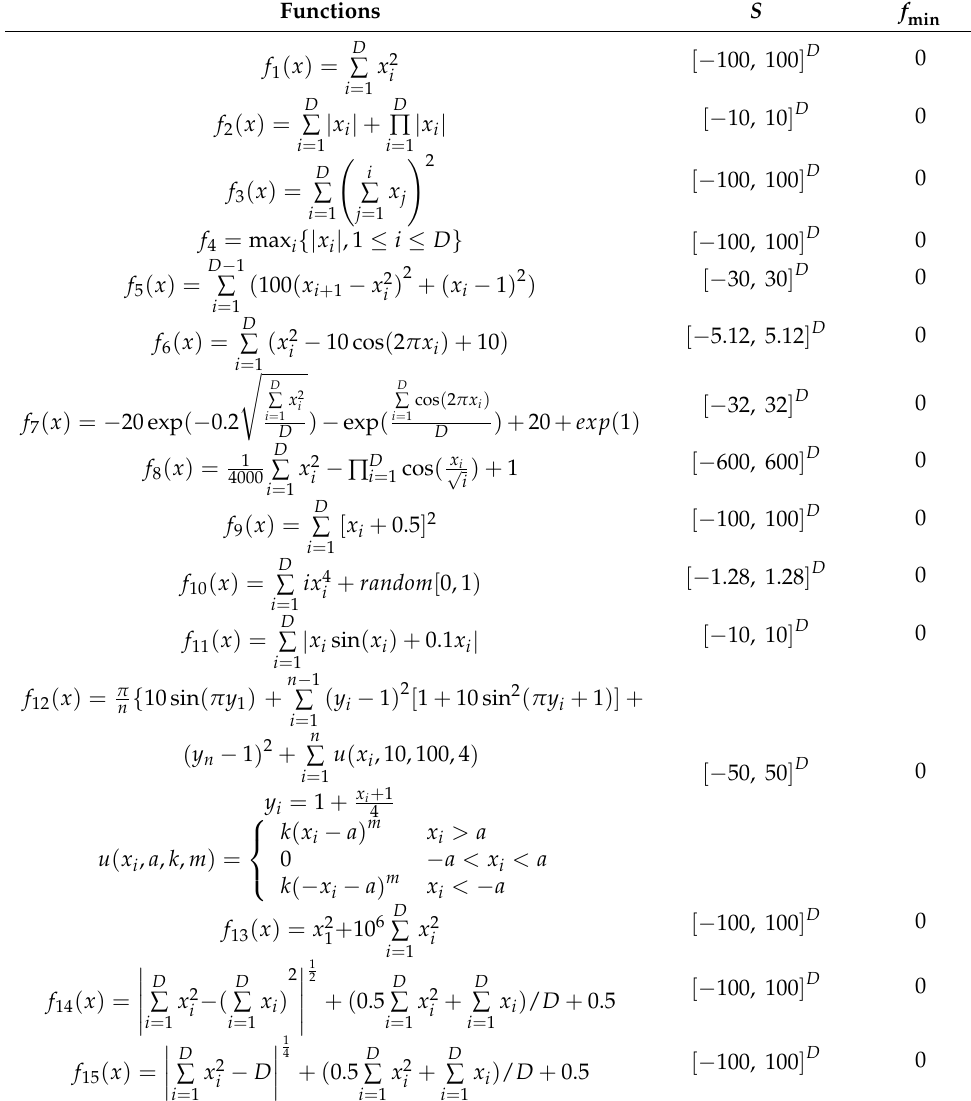
Table 1. Benchmark functions.